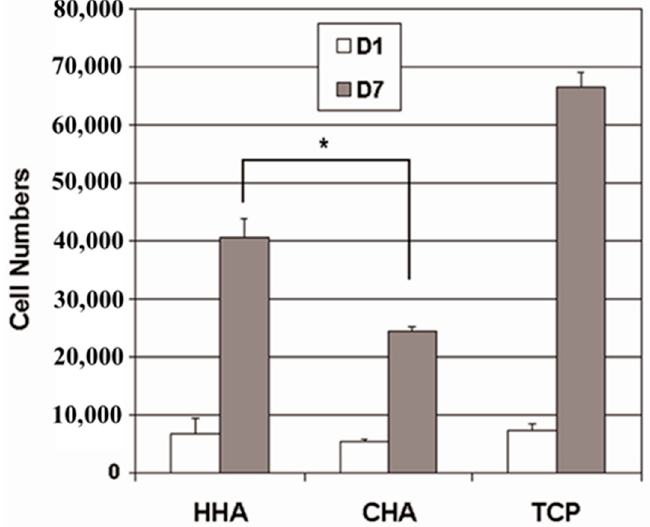
Figure 6. Proliferation of Saos-2 osteoblast-like cells on HHA and CHA scaffolds, and tissue plate (TCP) after 1 and 7 days (D1 and D7, respectively). * Significant di ff erence, p < 0.01. culture plate (TCP) after 1 and 7 days (D1 and D7, respectively). *Significant difference, p < 0.01.